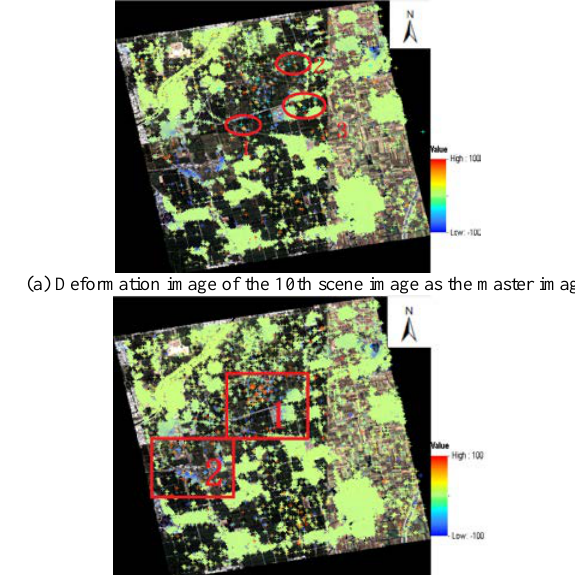
Figure 4. PS-InSAR deformation area distribution